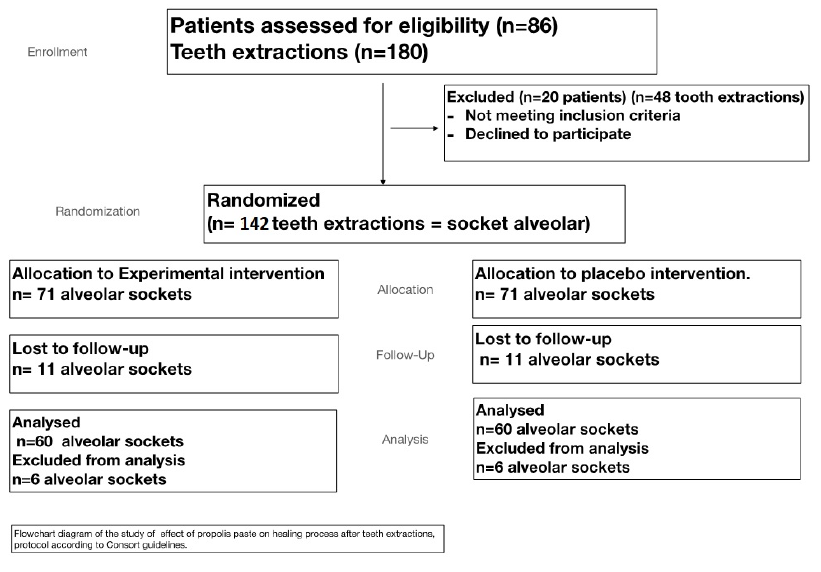
Figure 1. Flowchart of the toothpaste assay. Table 1. Healing ratios and statistical significance of patients treated with control or propolis